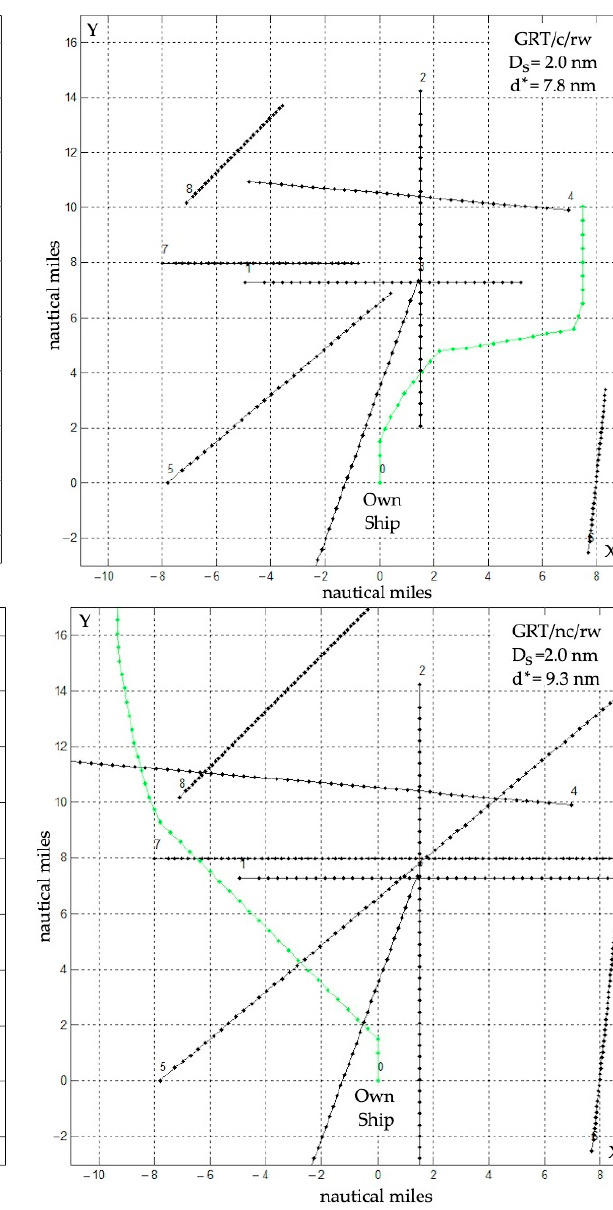
Figure 15. Safe game risk trajectory of one’s own ship determined by the GRT algorithm, in good (gw) and restricted (rw) visibility at sea, with the cooperation of vessels (c) and non-cooperation between vessels (nc); d* means the final deviation of the course of one’s own ship from the initial value after exiting the collision situation.